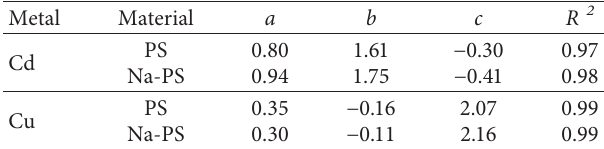
Note: PS means Pisha sandstone; Na-PS means Pisha sandstone modified with Na +